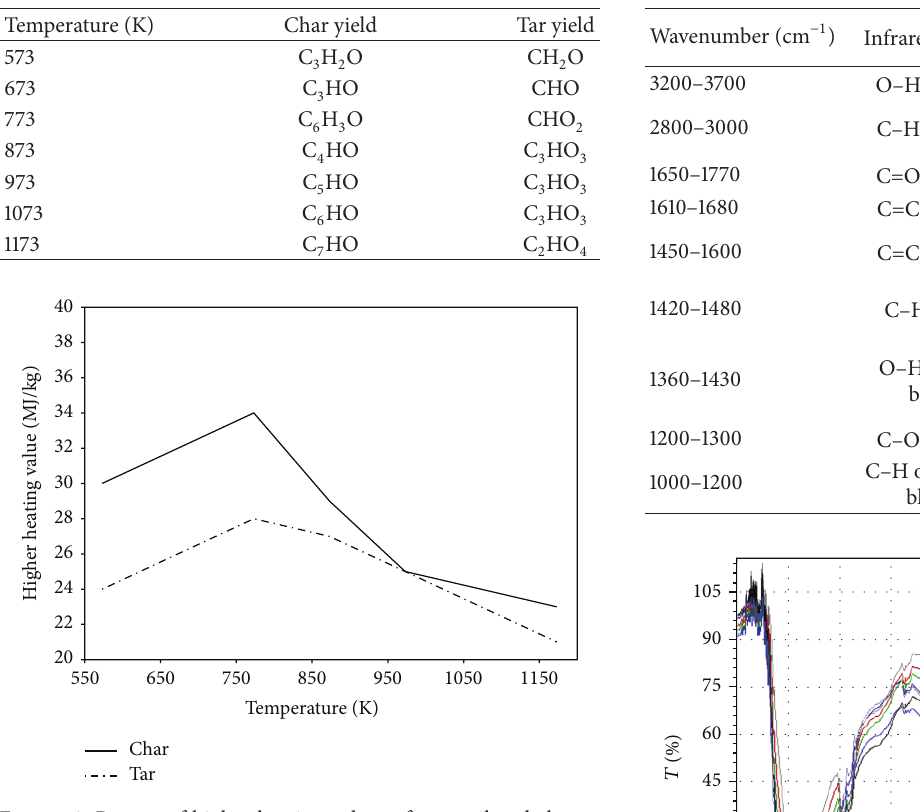
Figure 8: Pattern of higher heating values of pyro-oil and char at different pyrolysis temperature.